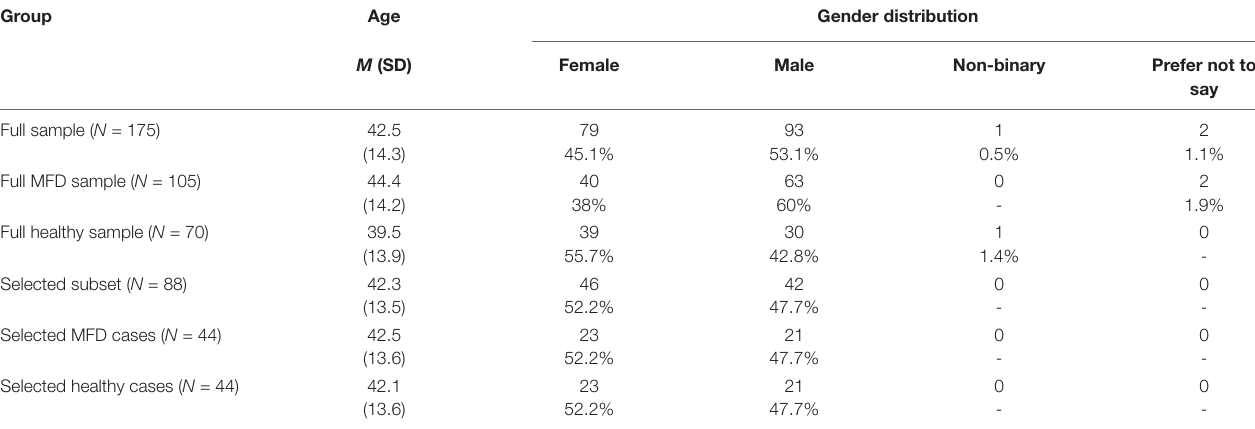
TABLE 1 | Age and gender characteristics of the samples. Group Age Gender distribution